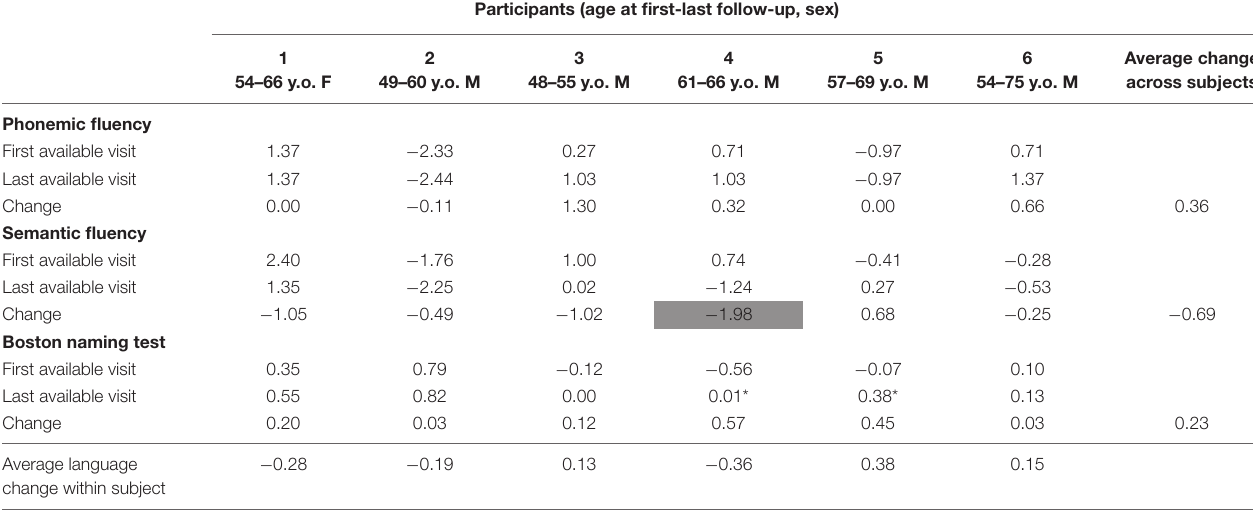
TABLE 5 | Language performance of the sample.